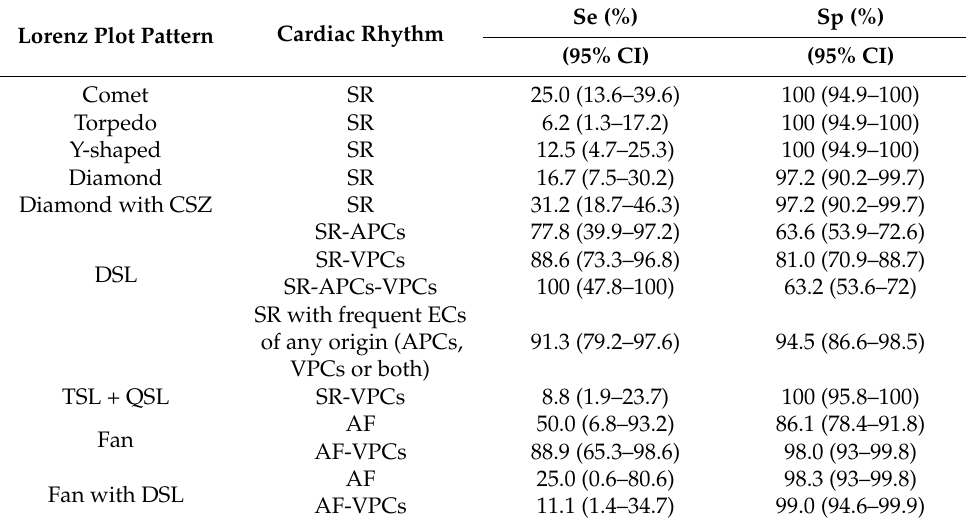
Table 6. Diagnostic value of Lorenz plot patterns for the diagnosis of cardiac rhythms. Lorenz Plot